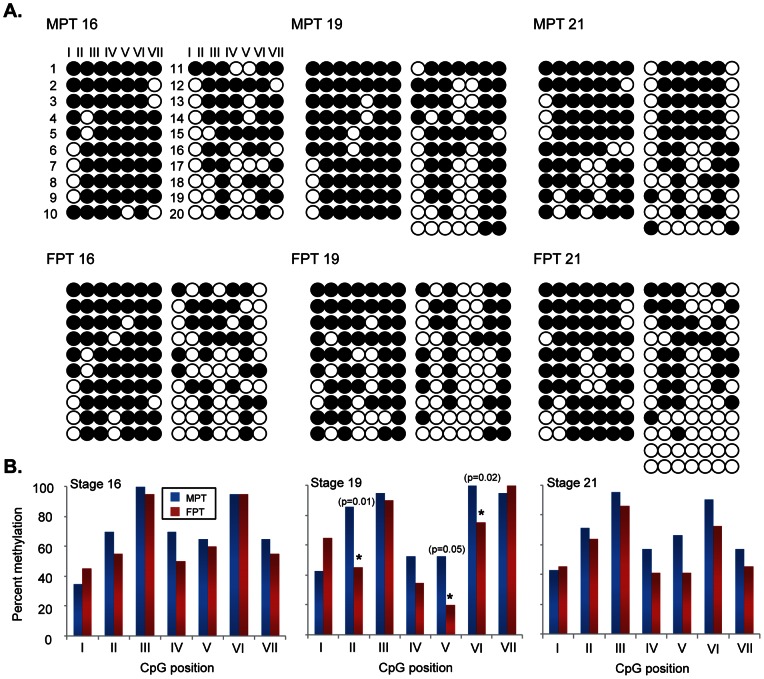
DNA methylation of the putative aromatase promoter at the individual CpG site in the gonads.(A) DNA methylation status in clones from the gonads at embryonic stage 16, 19, and 21 at MPT and FPT. Each row represents a single clone (1–20∼22 clones/stage/temperature) and a column represents the position of CpG (I – VII). Open circles: unmethylated CpG sites. Closed circles: methylated CpG sites. (B) Percent DNA methylation at the individual CpG site (I – VII) of the putative aromatase promoter at stage 16, 19, and 21 in the slider gonad. Asterisk (*) is statistically significant (p<0.05) according to the Fisher's exact test. MPT: male-producing temperature. FPT: female-producing temperature.